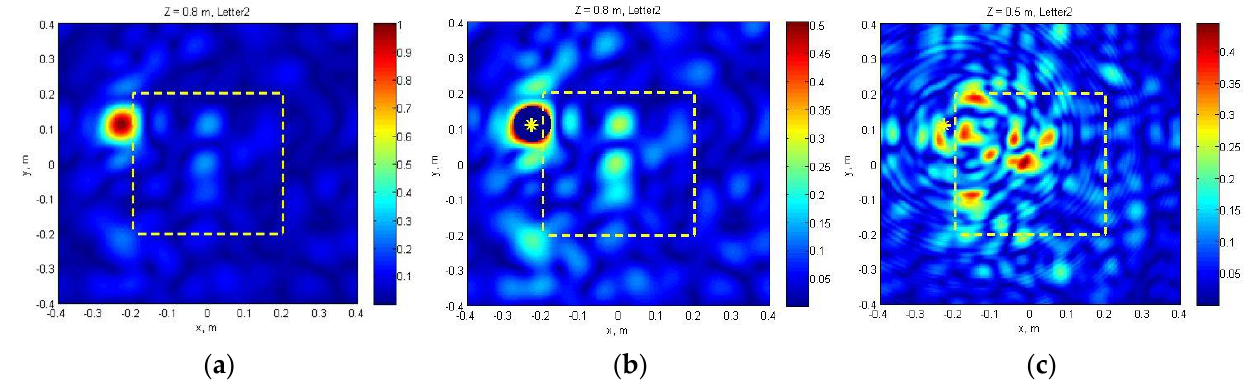
Figure 14. ( a ) Reconstructed wave field in the imaginary source plane; ( b ) mechanical cutting out of the source image; ( c ) migration to the object plane. Dotted line marks the holographic antenna contour, asterisk shows the radiator position.